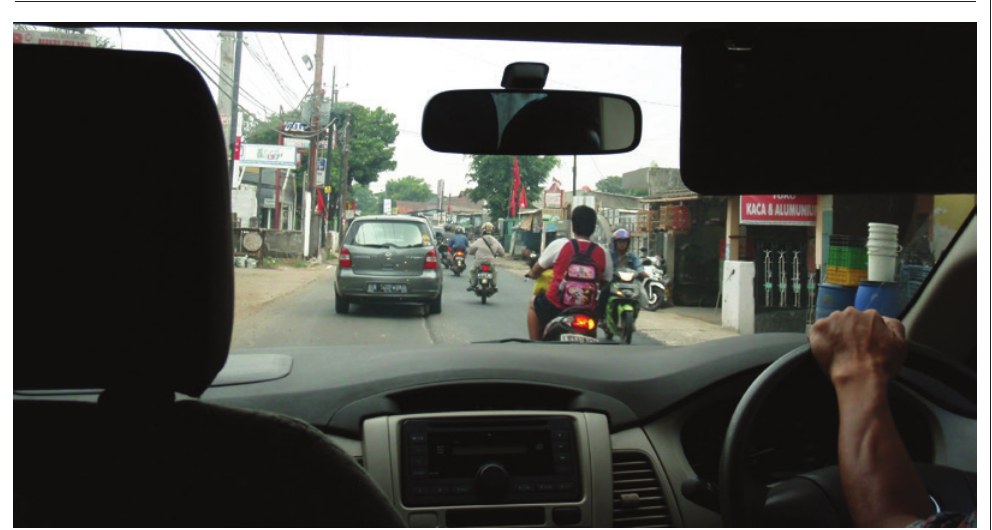
figure 1: Driving on the side roads to the school (Source: elisabeth barratt Hacking,